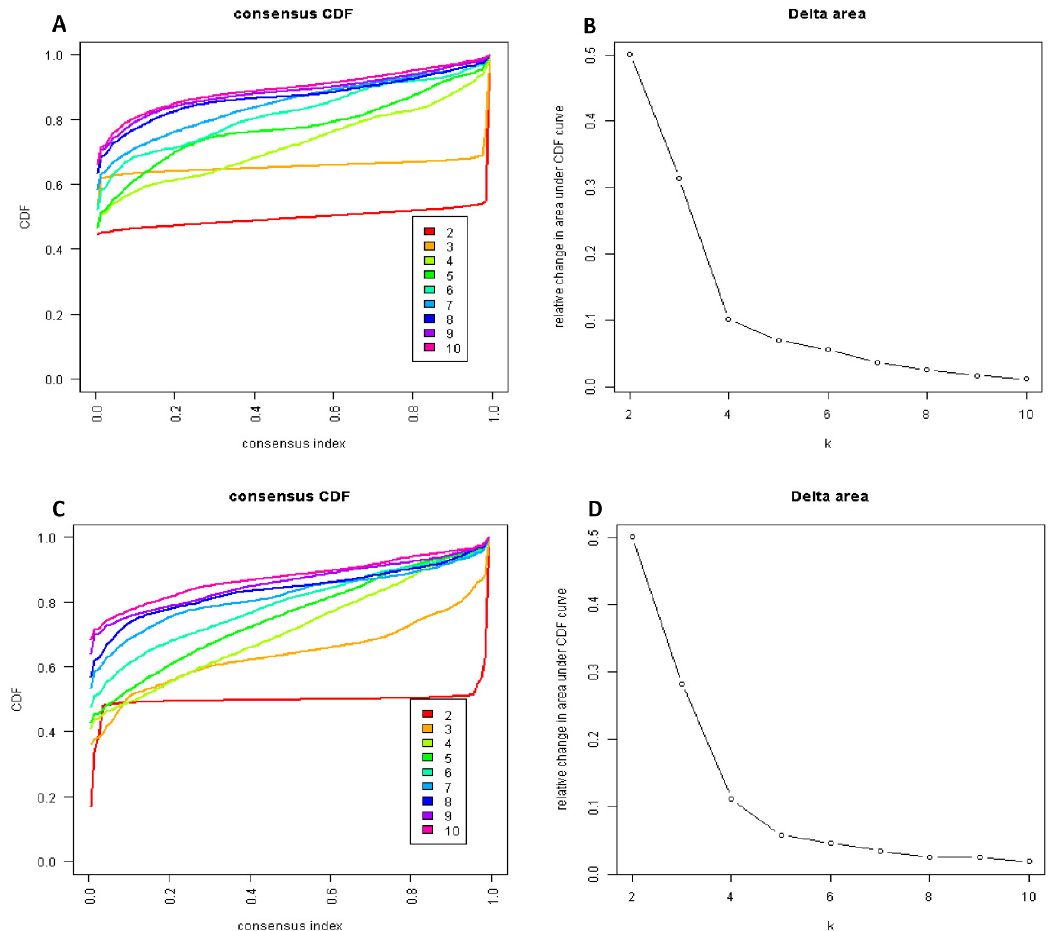
Figure 1. ( A ) Cumulative distribution function (CDF) plot displaying consensus distributions for each cluster (k) for patients with hypomagnesemia; ( B ) Delta area plot reflecting the relative changes in the area under the CDF curve for hypomagnesemia. ( C ) CDF plot displaying consensus distributions for each cluster (k) for patients with hypermagnesemia; ( D ) Delta area plot reflecting the relative changes in the area under the CDF curve for hypermagnesemia.